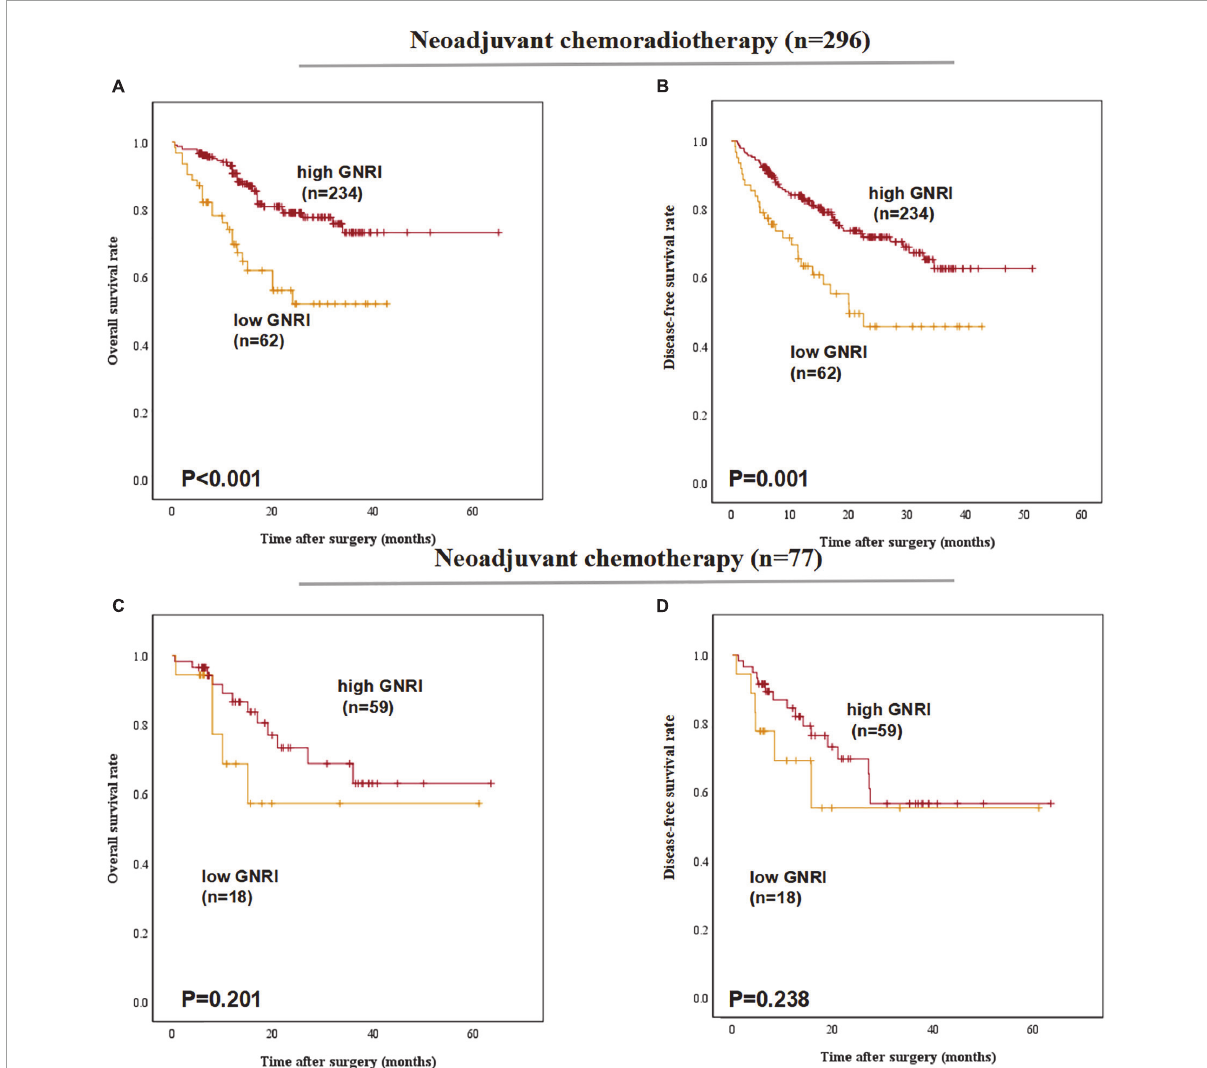
FIGURE4 Postoperative outcomes of patients with high or low geriatric nutritional index (GNRI) basing on different preoperative treatment: (A) overall survival, (B) disease-free survival of ESCC patients underwent neoadjuvant chemoradiotherapy ( n = 296), (C) overall survival, and (D) disease-free survival of ESCC patients underwent neoadjuvant chemotherapy ( n =